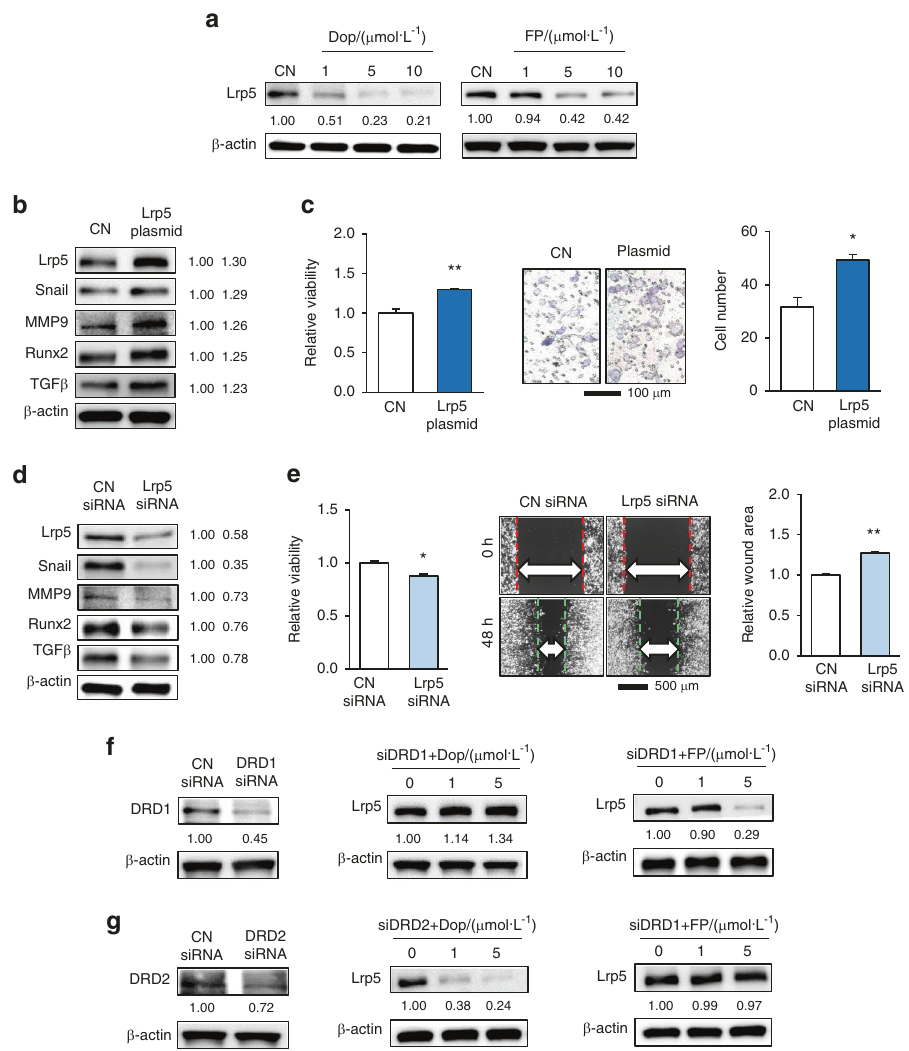
Fig. 5 Downregulation of Lrp5 by dopamine and fl uphenazine in 4T1Br cells. CN control, Dop dopamine, FP fl uphenazine, siDRD1 DRD1 siRNA, siDRD2 DRD2 siRNA. The single and double asterisks indicate P < 0.05 and 0.01, respectively. a Reduction in Lrp5 by dopamine and fl uphenazine. b Elevation of Snail, MMP9, Runx2, and TGF β upon the overexpression of Lrp5. c Promotion of MTT-assessed viability and Transwell-measured invasion by the overexpression of Lrp5. d Reduction in Snail, MMP9, Runx2, and TGF β levels by the silencing of Lrp5. e Decrease in MTT-assessed viability and scratch assay-measured migration by the silencing of Lrp5. f Suppression of dopamine-driven downregulation of Lrp5 by the silencing of DRD1. FP-driven downregulation was not suppressed. g Suppression of FP-driven downregulation of Lrp5 by the silencing of DRD2. Dopamine-driven downregulation was not the novel possibility of treating breast-cancer-associated brain metastasis via mechanical loading, the study has limitations. Our experiments used a mouse brain-metastasized tumor cell line and breast-cancer cell lines. The dopamine response depends on the expression level of dopamine receptors, and the ef fi cacy may depend on cancer cell types. In addition, the loading conditions are largely different in preclinical studies with small animals and clinical applications. The proper loading force may depend on its in situ or remote use. We employed a 5-N force to induce remote tumor-suppressing effects in this study, whereas the previous study for suppressing tumor progression in the loaded tibia employed a 1-N force. 3 Based on the difference in the diameter of the mouse and human tibiae in the midshaft (1.3 mm vs. 22 mm), the cross-sectional area differs by ~300-fold, and 5-N loads to mice may correspond to 1 500 N to humans. The internal loads to the tibia in humans are predicted to be as high as 4.7 bodyweights. 34 For a person with a body weight of 65 kg, the maximum load is ~3 000 N. The required loads are not proportional to bodyweights